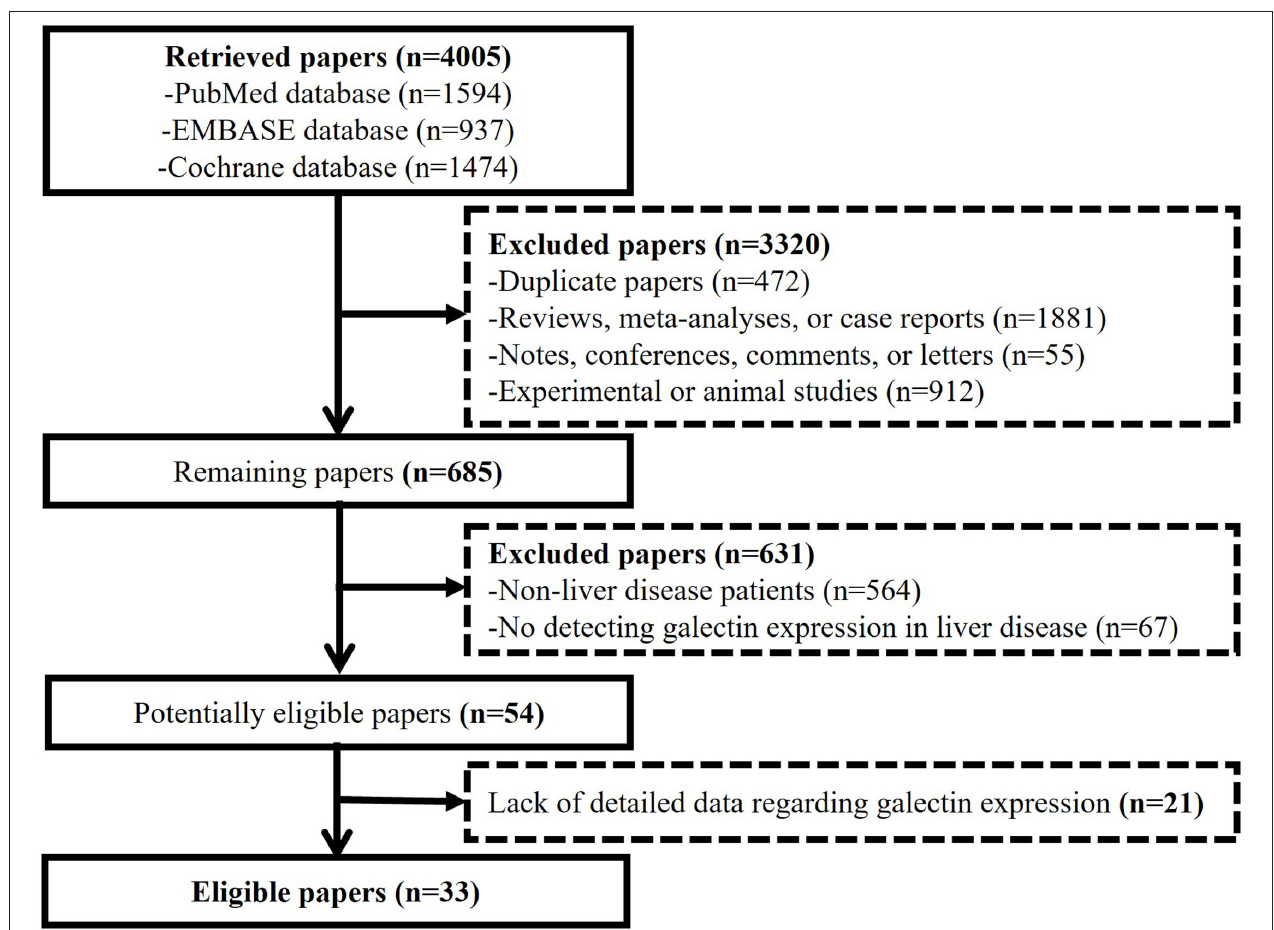
FIGURE 1 | Flow diagram for the selection of the